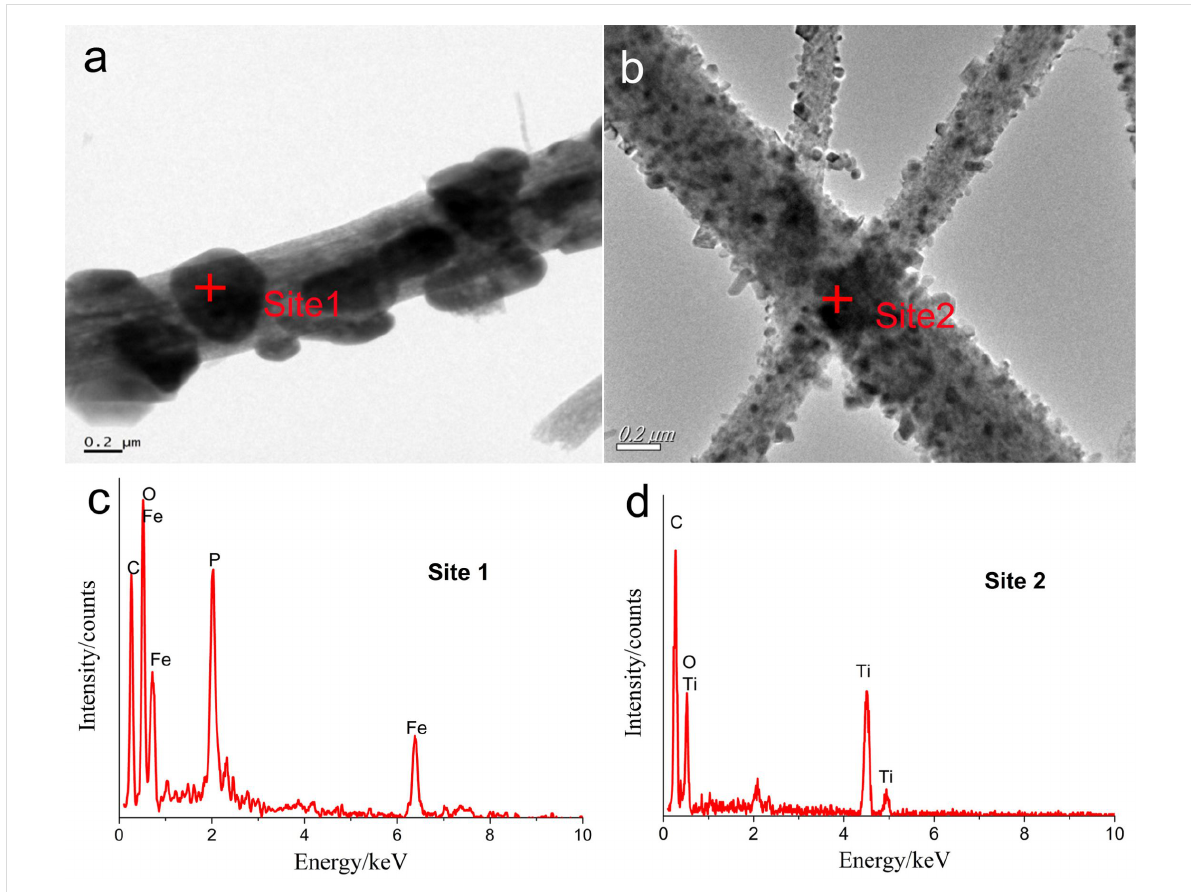
Figure 4: TEM pictures and EDS spectra of LiFePO 4 and Li 4 Ti 5 O 12 fibers. (a)TEM of a LiFePO 4 fiber; (b) TEM of Li 4 Ti 5 O 12 fibers; (c)EDS of LiFePO 4 at site 1; (d) EDS of Li 4 Ti 5 O 12 at site 2.